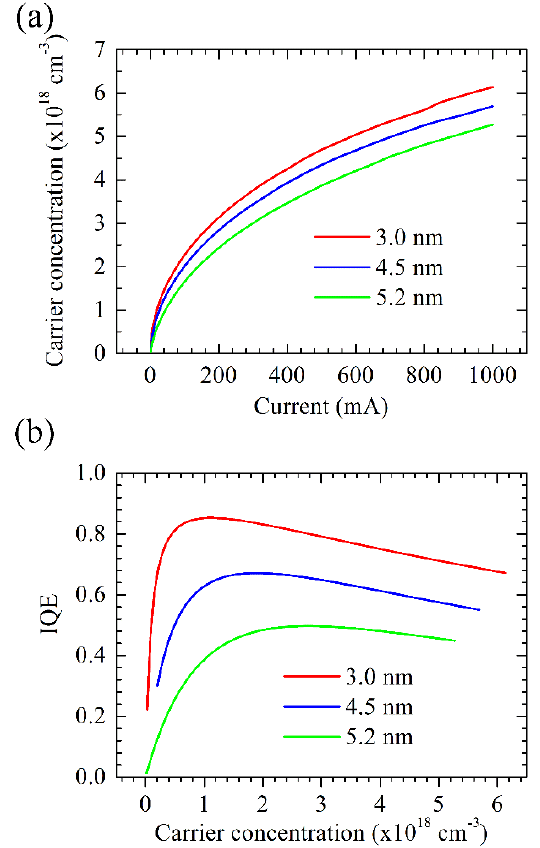
Figure 4. ( a ) The relationship between the current and ( b ) internal quantum efficiency (IQE) versus carrier density for the three LEDs with various LQW thicknesses.